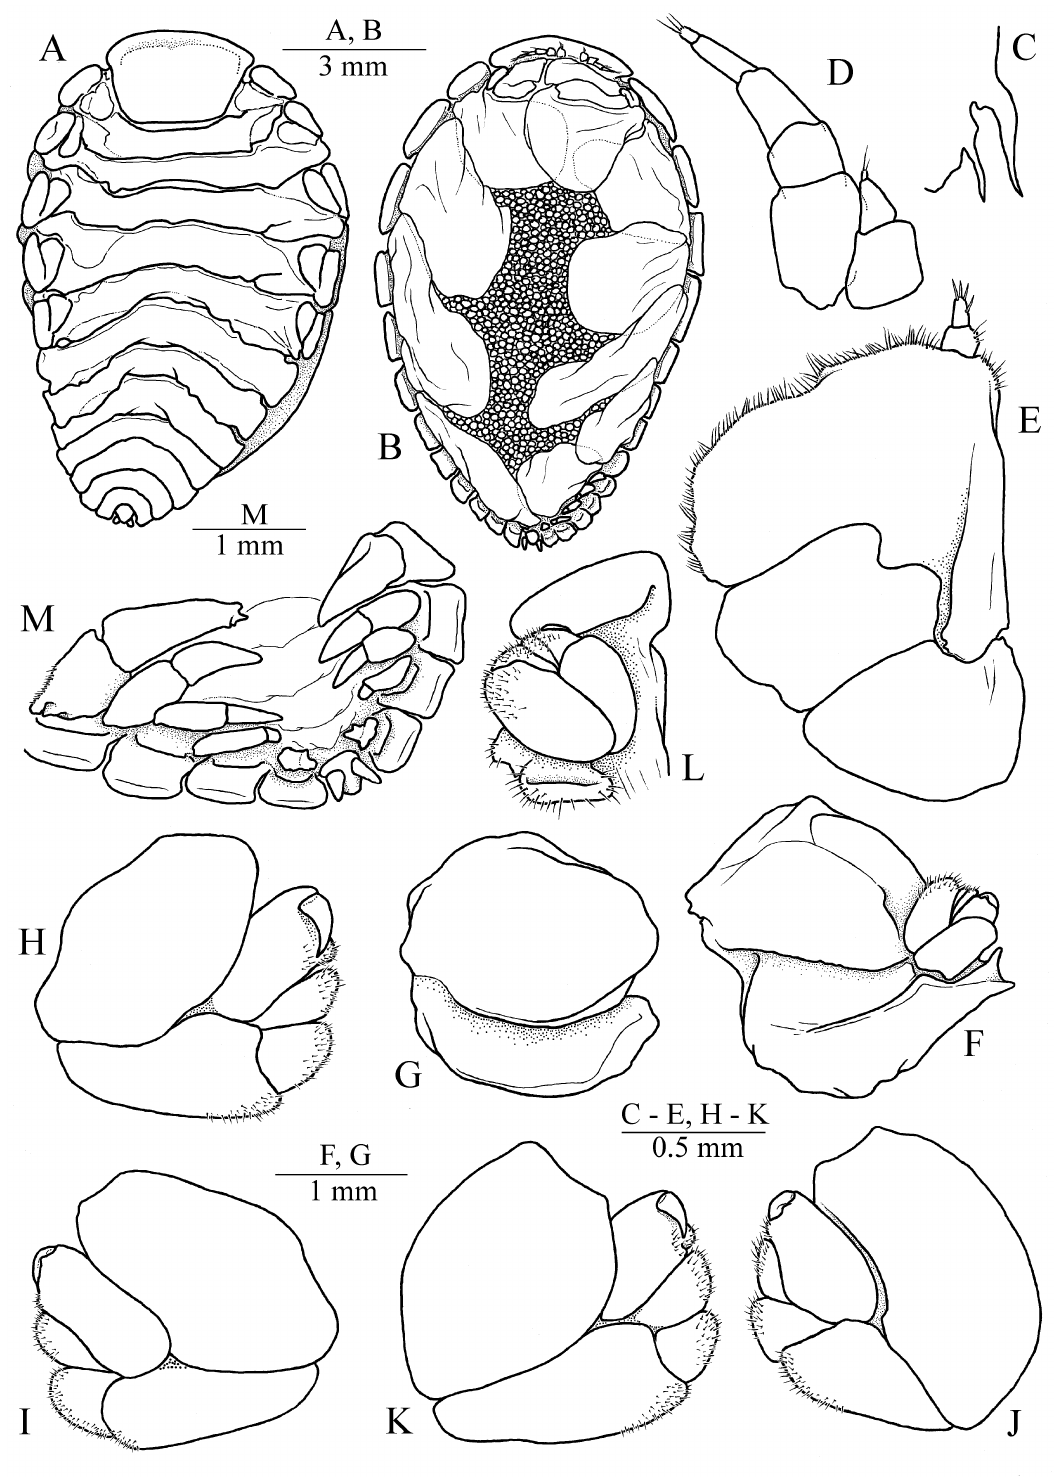
Fig. 2. Pleurocryptella altalis sp. nov., holotype, ♀ (ZMMU Mc 1420). A . Dorsal view. B . Ventral view. C . Left barbula. D . Right antennule and antenna. E . Left maxilliped, external view. F . Left oostegite 1, external view with pereopod 1 attached. G . Left oostegite 1, internal view. H – I . Left pereopod 1, lateral view. J – K . Left pereopod 7, lateral view. L . Left pereopod 7 and oostegite, lateral view. M . Pleon, ventral